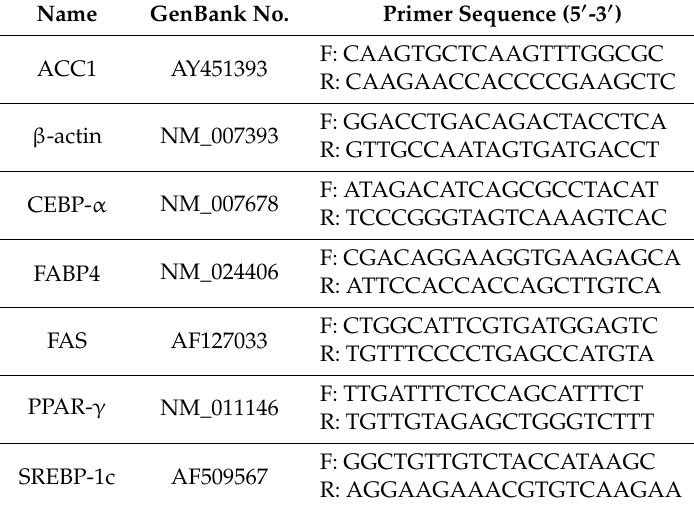
Table 1. Primers used for